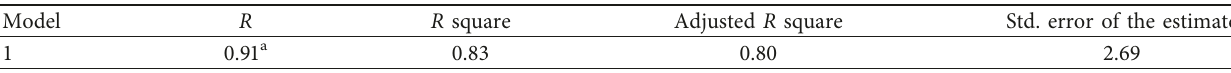
Table 3: Fitness of model for red soil.